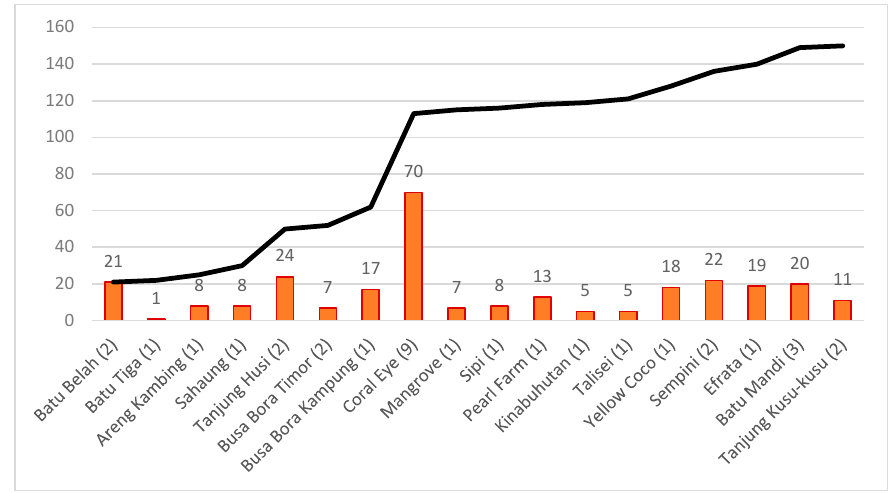
Figure 25. Species accumulation curve (black line) and number of species per locality (red bars). Numbers in brackets after the locality name indicate the number of sampling events at that particular site. Note the high number of sampling events at the locality Coral Eye.